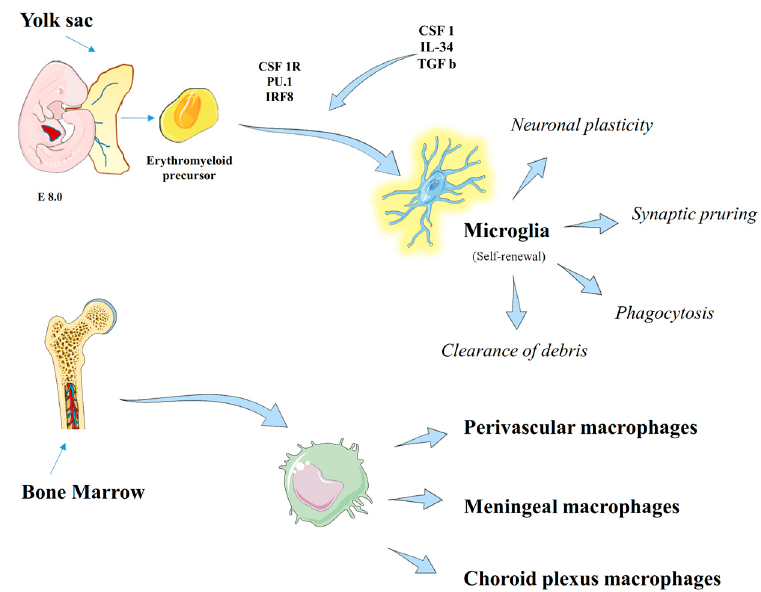
Figure 1. Origin of parenchymal and non-parenchymal CNS macrophages. This figure was drawn using the vector image bank of Servier Medical Art (http://smart.servier.com/). Servier Medical Art by Servier is licensed under a Creative Commons Attribution 3.0 Unported License (https://creativecommons.org/licenses/by/3.0/).